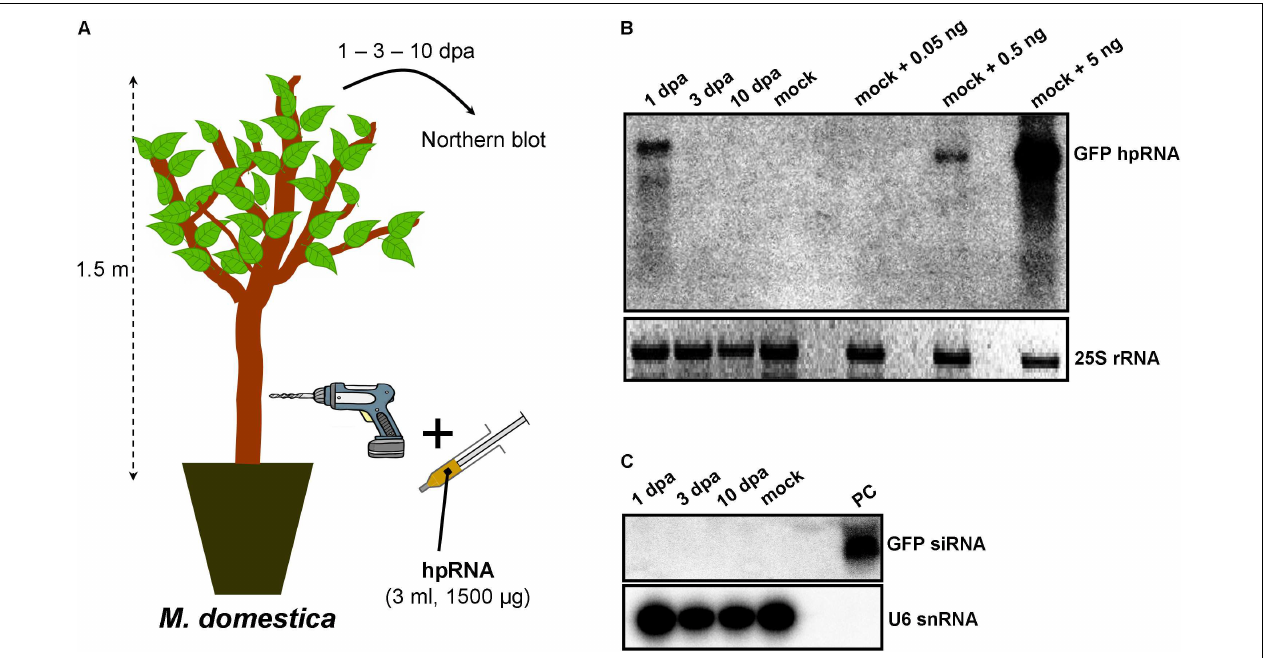
FIGURE 1 | Delivery of exogenous hpRNA (500 nt) in apple by trunk drilling. (A) Apical leaves were harvested 1, 3, and 10 dpa and total RNA was extracted. (B) Northern blot for the detection of GFP hpRNA. Total RNA (5 µ g) was analyzed in a 1.2% agarose/formaldehyde gel and the full-length GFP cDNA fragment (792 bp) was used as a hybridization probe. Mock RNA (from non-treated M. domestica plants) was spiked with dilutions of 5, 0.5, and 0.05 ng input hpRNA to demonstrate that in systemic leaves, the detected hpRNA is of the same size as the input hpRNA. The ethidium bromide stained gel depicts the 25S rRNA band and serves as an RNA loading control. (C) Northern blot for the detection of GFP siRNAs. Total RNA (20 µ g) was analyzed in a 15% polyacrylamide gel and the full-length GFP cDNA fragment (792 bp) was used as a hybridization probe. As a positive control (PC) in vitro synthesized 22-nt GFP siRNAs (100 ng) were included. Hybridization of the membrane with a DNA oligo detecting the U6 snRNA served as an RNA loading control.